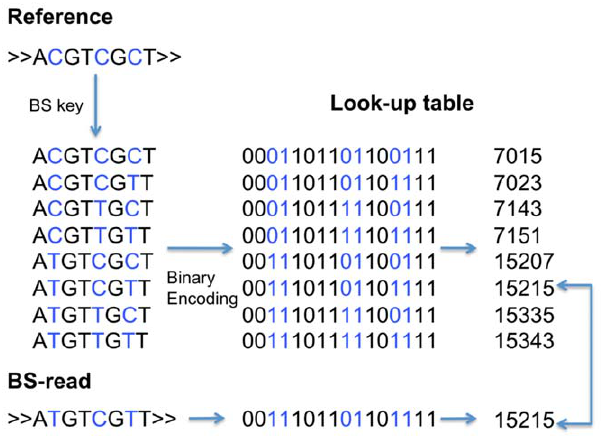
Figure 5. Example for an asymmetric look-up table for 8 k- mers. The 8-mer ACGTCGCT (corresponds to key 7015) generates 7 other keys. The 8-mer ATGTCGTT (key 15215) from the BS-read can be looked up to find its referenced key as ACGTCGCT (key 7015), ACGTCGTT (key 7023), ATGTCGCT (key 15207) and ATGTCGTT (key 15215) but no others.